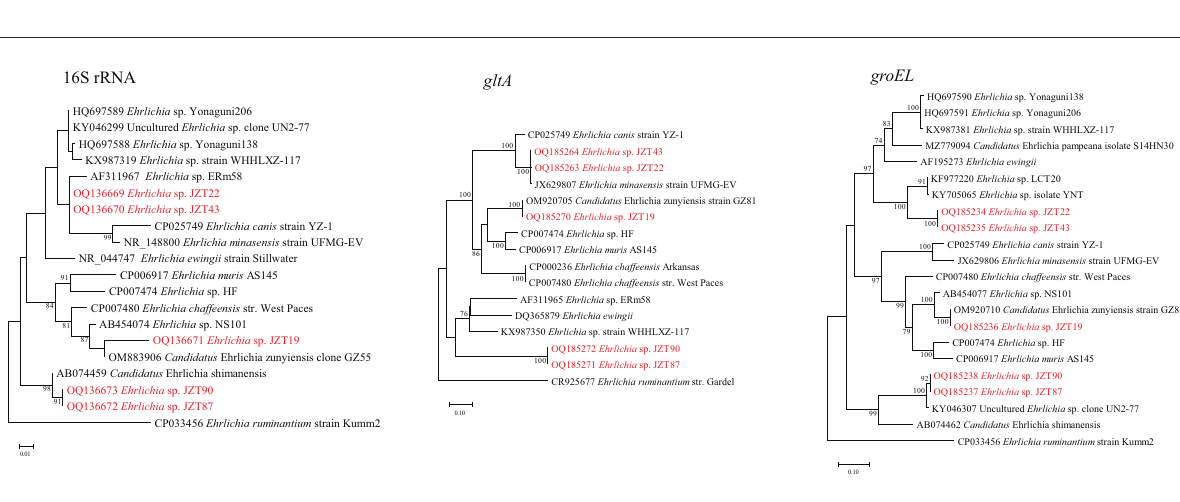
FIGURE6 Phylogenetic trees constructed using PhyML 3.0 based on the nucleotide sequences of the 16S rRNA (1,433 bp), gltA (978–1,234 bp), and groEL (1,224 bp) genes of Ehrlichia strains. Sequences obtained in this study are marked in